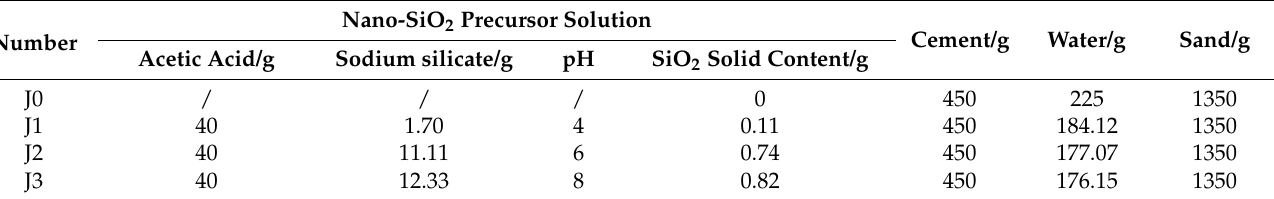
Table 6. The ratio of precursor solution with different alkalinity levels.